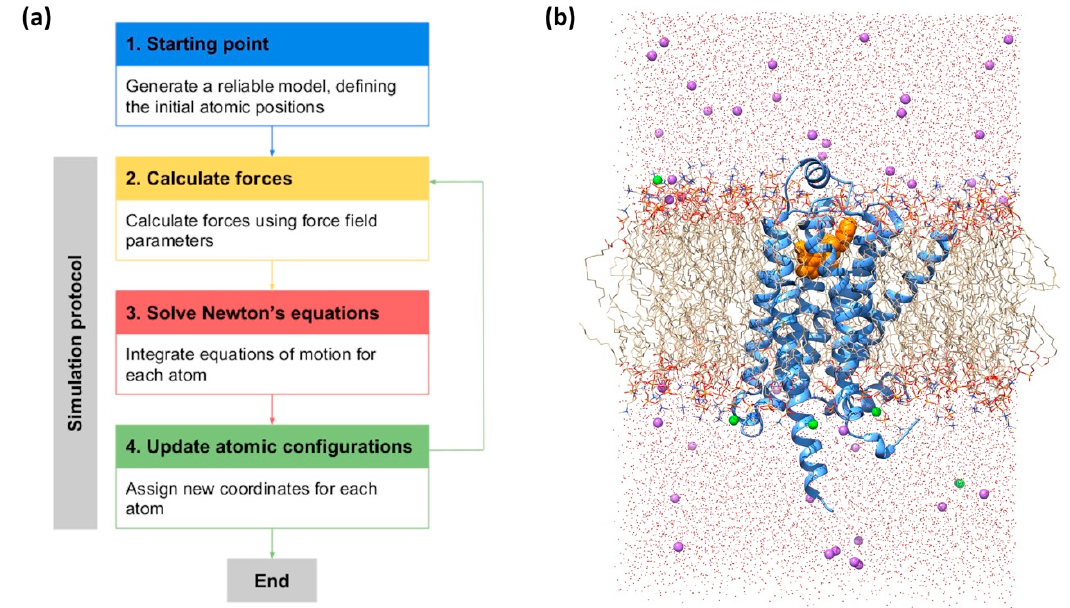
Figure 3. ( a ) Flowchart summarizing the stages of a MD simulation. ( b ) Example of a GPCR molecular system, including the β -2 adrenergic receptor ( β 2AR, blue) with a full agonist in the binding site (orange) in a 1-palmitoyl-2-oleoyl-sn-glycero-3-phosphocholine (POPC) membrane (tails in light brown, heads colored by heteroatom). The system is solvated with water (red) and ionized with sodium (green) and chloride (purple) ions.